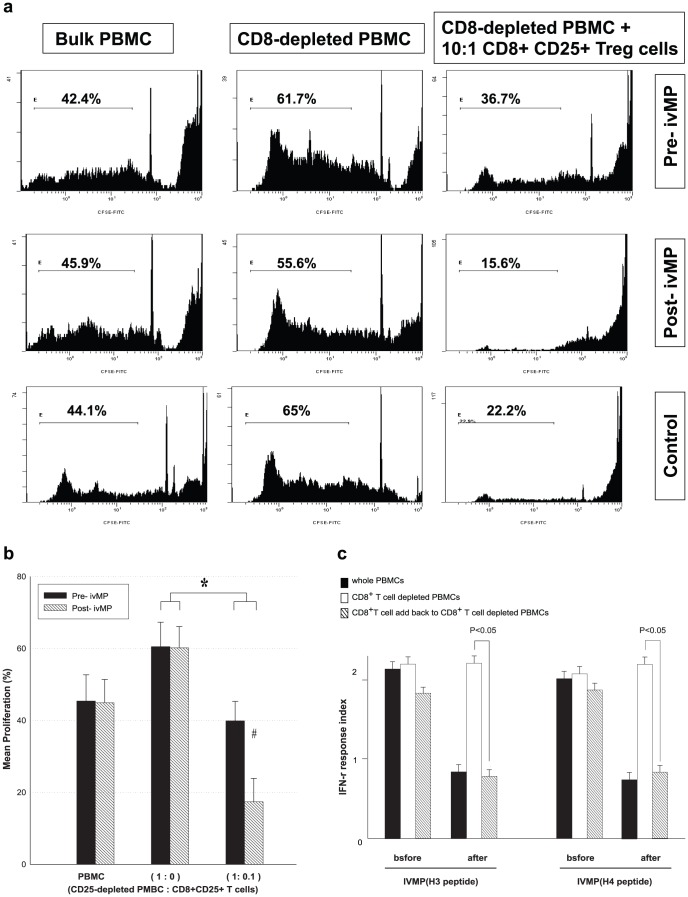
CD4+ cell proliferation in the presence of CD8+CD25+ Treg cells during IVMP.(a) CFSE-labeled cells (Bulk PBMCs and CD8+-depleted PBMCs) were pretreated with anti-CD3 mAb for five days, CD8+-depleted PBMCs incubated with purified CD8+CD25+ T cells at a ratio of 10:1, proliferation of CD4+ T cells analyzed by flow cytometry. (b) There was significant suppression (*) of CD+ cells proliferation in the presence of CD8+CD25+ regulatory T cells compared to CD8+ depleted PMNCs alone. There was significant suppression (#) of CD4+ T cell proliferation after IVMP during SLE, data calculated from 20 paired experiments. (*# indicates p<0.05). (c) Th1 type IFN-r response to critical peptide epitopes (H3: 115–135, H4: 16–39) in PBMCs of LN patients before and after IVMP pulse therapy. CD8+ T cells significantly suppressed IFN-r response after IVMP pulse therapy. Data were calculated from 20 paired experiments; bars represent mean ± SD.